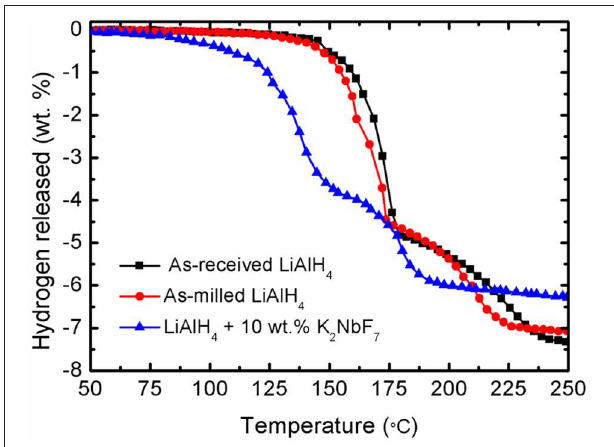
FIGURE 1 | TPD profile for the as-received LiAlH 4 , as-milled LiAlH 4 , and LiAlH 4 + 10 wt.% K 2 NbF 7 .